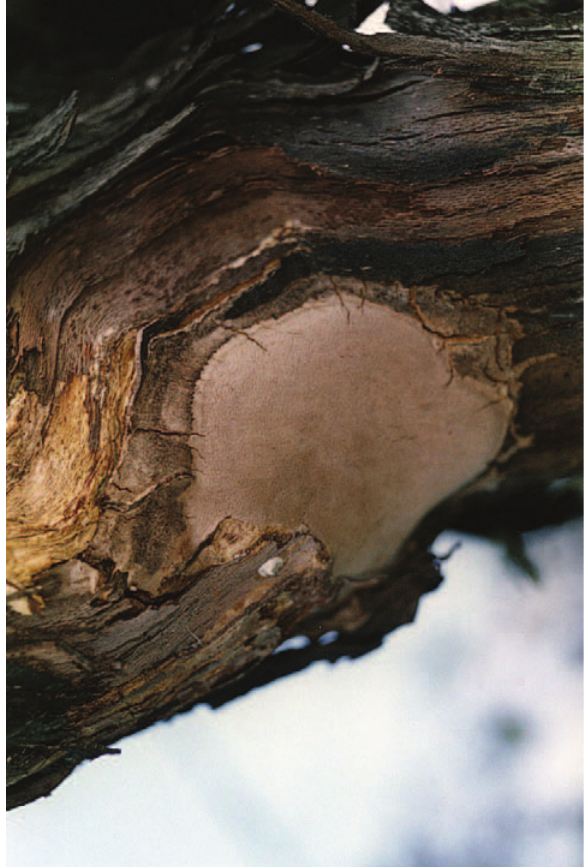
Fig. 6. Carpophore of Fomitiporia mediterranea on an old trunk of grapevine. Photo Claudio Ciccarone, Fog- gia,